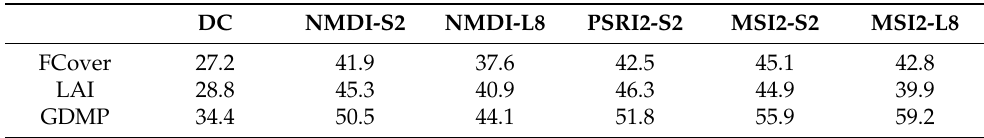
Table 8. Correlation coefficients (in %) between the environmental indicators and the spectral indices used in the area-based validation process.